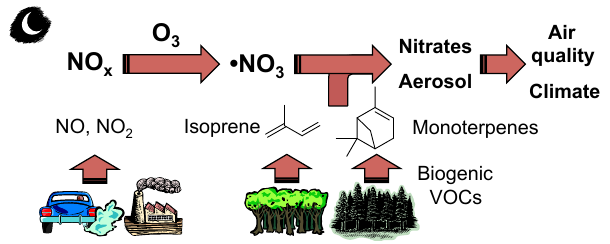
Figure 1. Schematic of nighttime NO 3 -BVOC